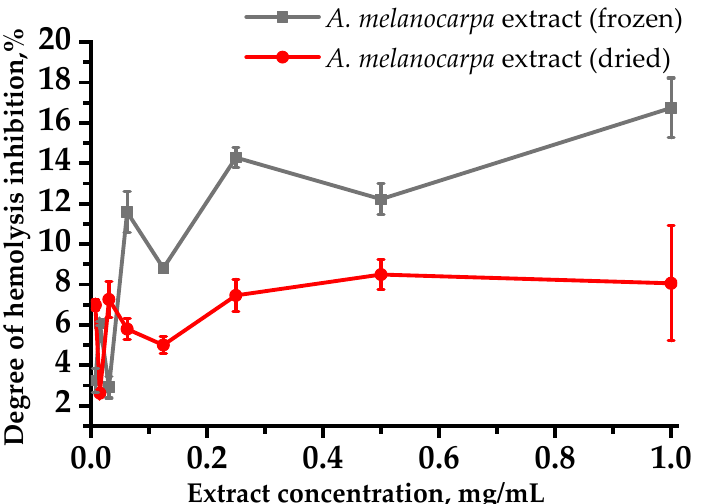
Figure 2. Dependence of red blood cell osmotic hemolysis on the aronia extract concentration on the model system. Values are expressed as percent inhibition (mean ± SD).